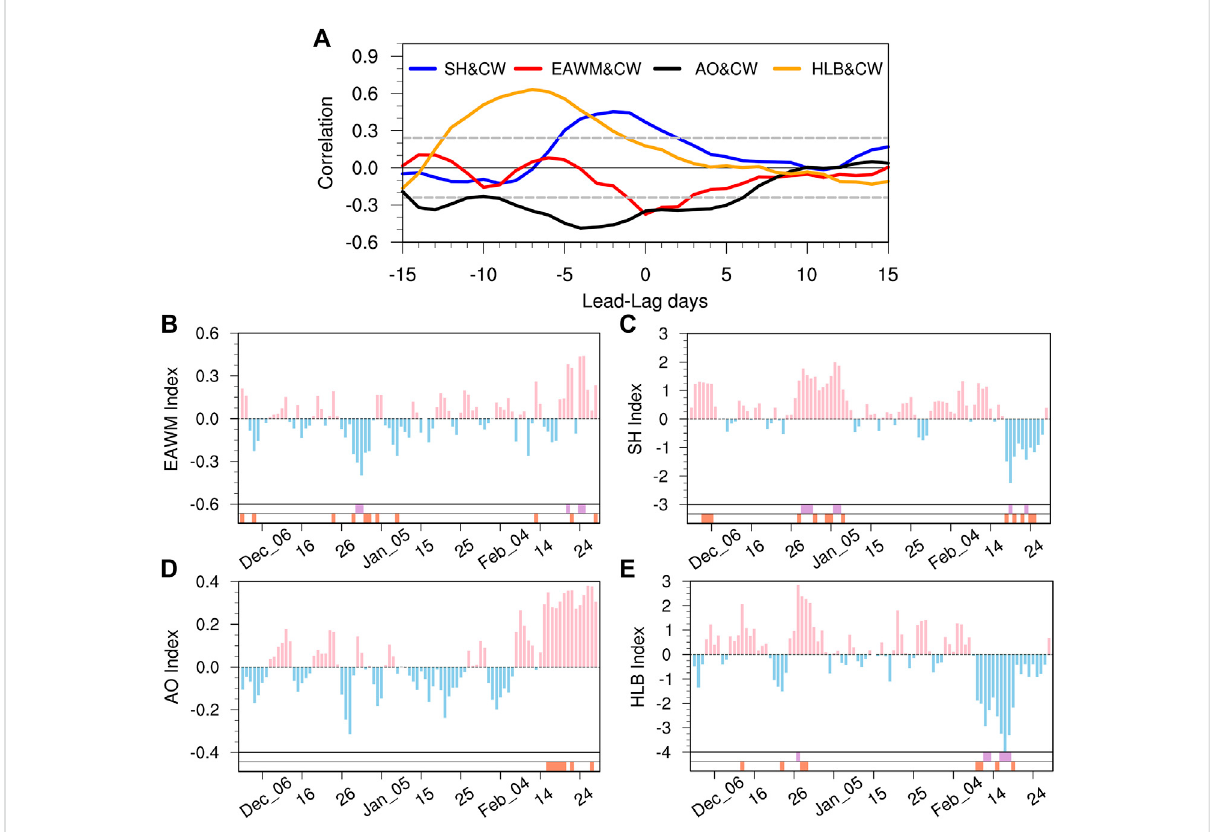
FIGURE 2 (A) Correlation coef fi cient between the trend of different atmospheric circulation indices and ECEs over eastern China in winter. The gray dotted lines are p < 0.05 and − 5 days represents the daily trend of the circulation index leading the daily trend of ECEs by 5 days. Daily trends of atmosphericcirculation indices in winter: (B) EAWM, (C) SH, (D) AO and (E) HLBs. The lower row of small histograms represents signi fi cance tests, as in Figure 1A.